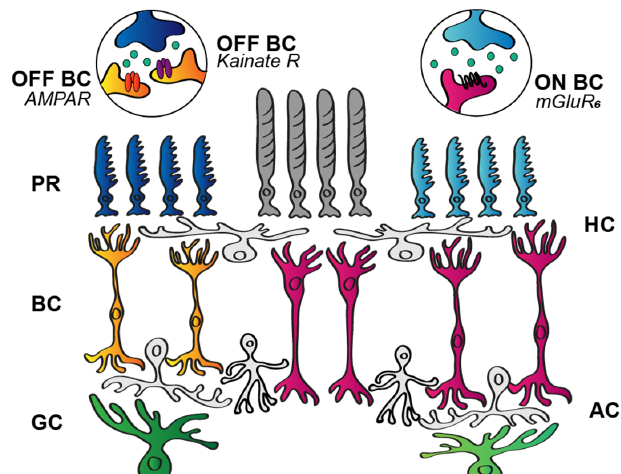
Figure 3. Excitatory signal processing in the outer retina. Photoreceptors (PR; dark grey, dark and light blue) release glutamate that binds to postsynaptic glutamate receptors located on dendrites of bipolar cells (BCs). OFF BCs (orange) express either AMPA or kainate ionotropic receptors that, upon glutamate binding, excite BCs. In contrast, ON BCs (magenta) have the metabotropic